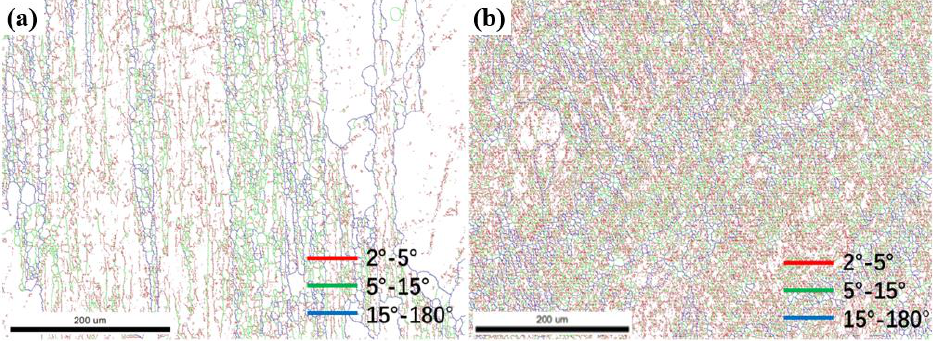
Figure 5. Small angle grain boundary maps ( a ) T6; ( b ) 200 °C.